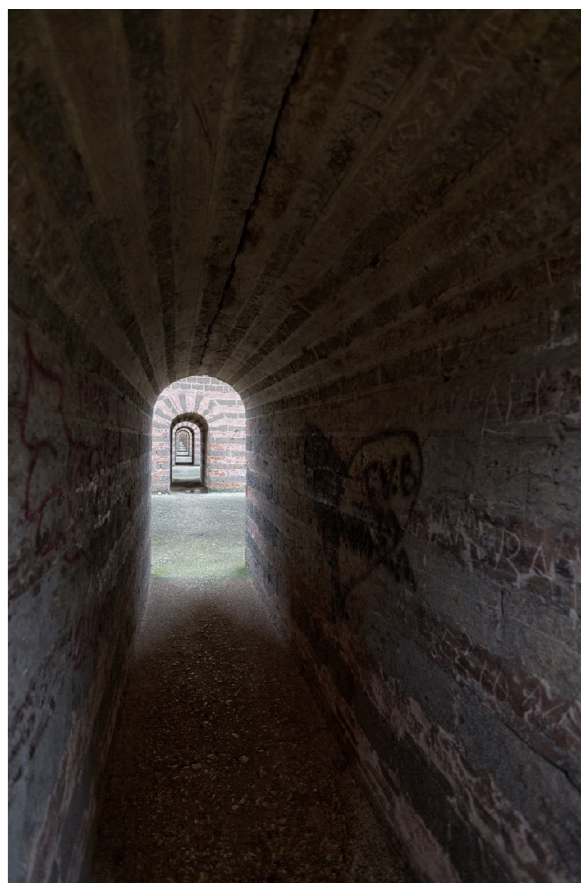
Figure 5 . ‘Carolino’ Aqueduct. ‘Ponti della Valle’ (Credit: Luca Canonici)